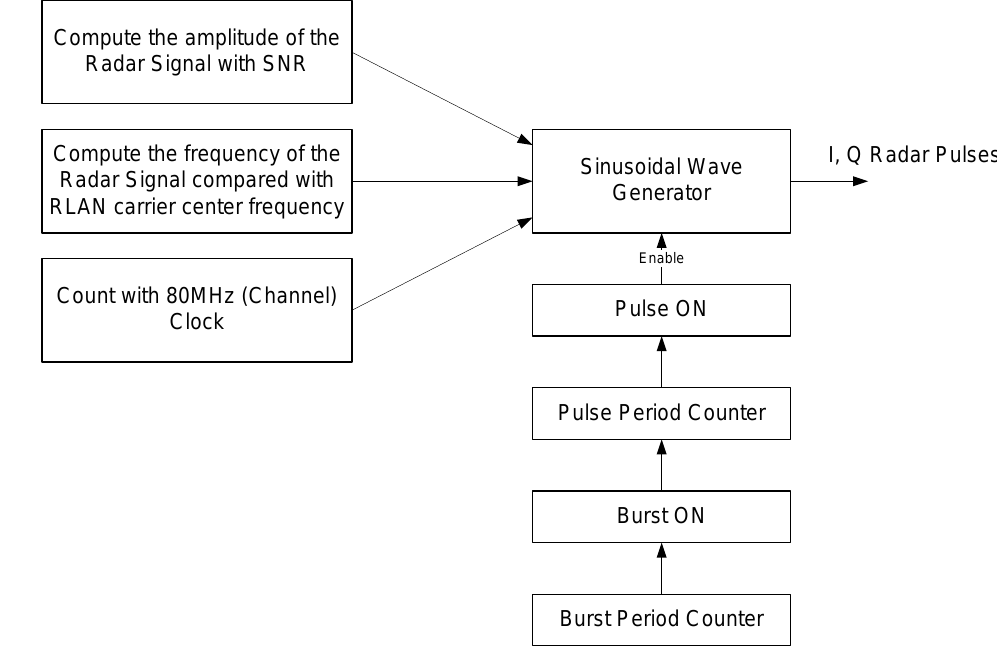
Figure 4. Block diagram of the radar transmitter.